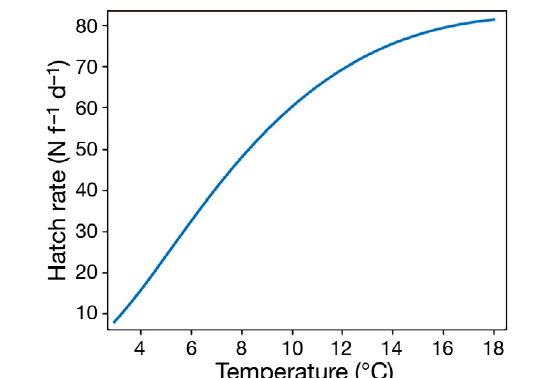
Fig. 2. Calculated hatch rate of salmon louse eggs per adult female salmon louse per day as a function of ambient temperature